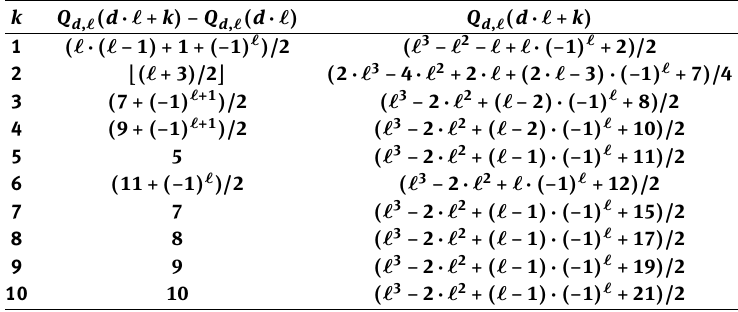
Table 1. Behaviour of Q d , (cid:96) ( d ⋅ (cid:96) + k ) for (cid:96) ≥ 2 ⋅ k + 1 and k ≤ 10 where d = (cid:96) ⋅( (cid:96) − 1 )− 1 +(− 1 )